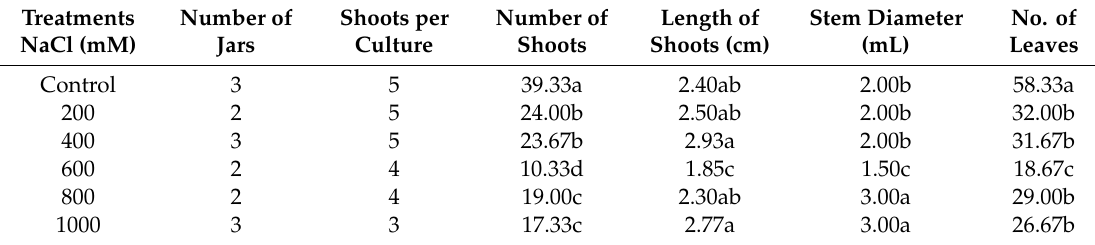
Table 1. Treated jojoba plants growing on MS medium with di ff erent levels of NaCl (NaCl from 400, 600, 800 and 1000 mM of NaCl). Shoot number, leaf number, and plant length were determined in the table and in